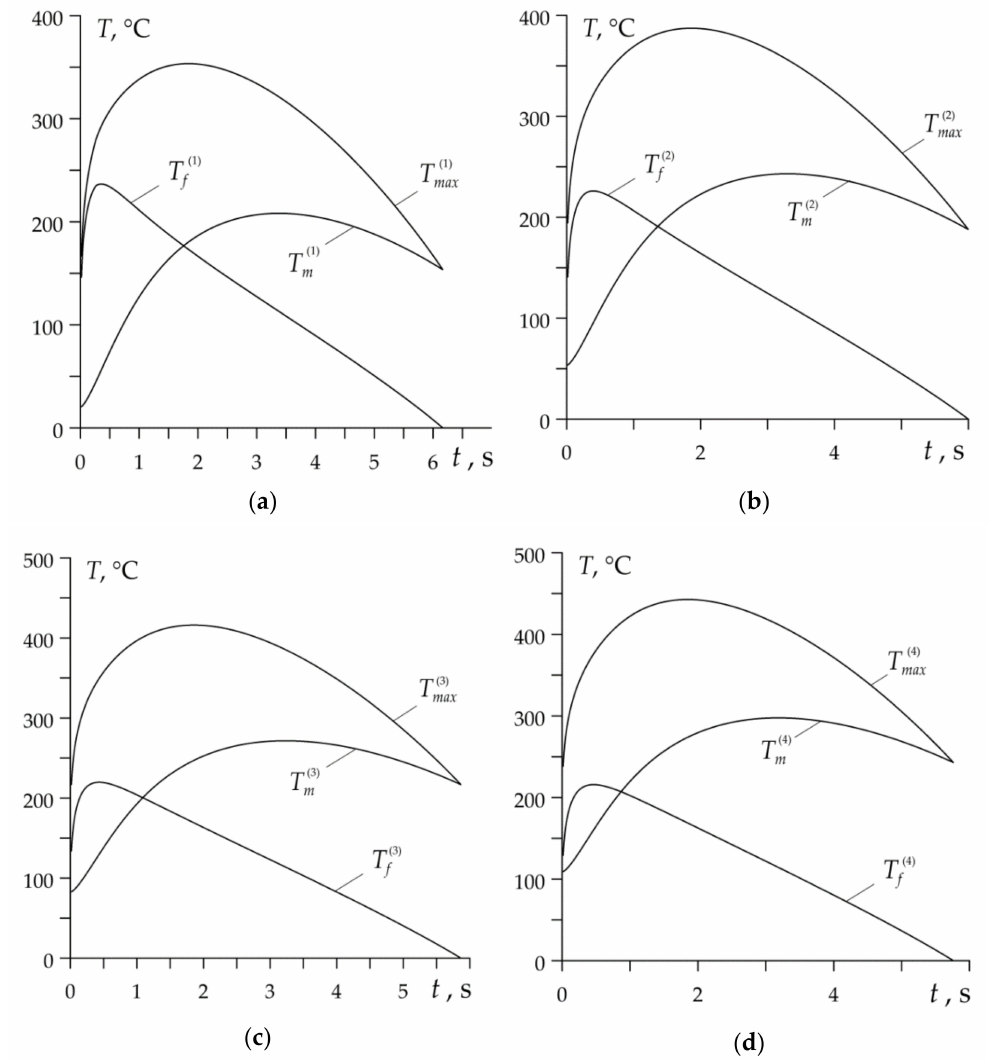
( k ) ( k ) ( k ) and maximum T m , flash T max temperatures for drum brake f